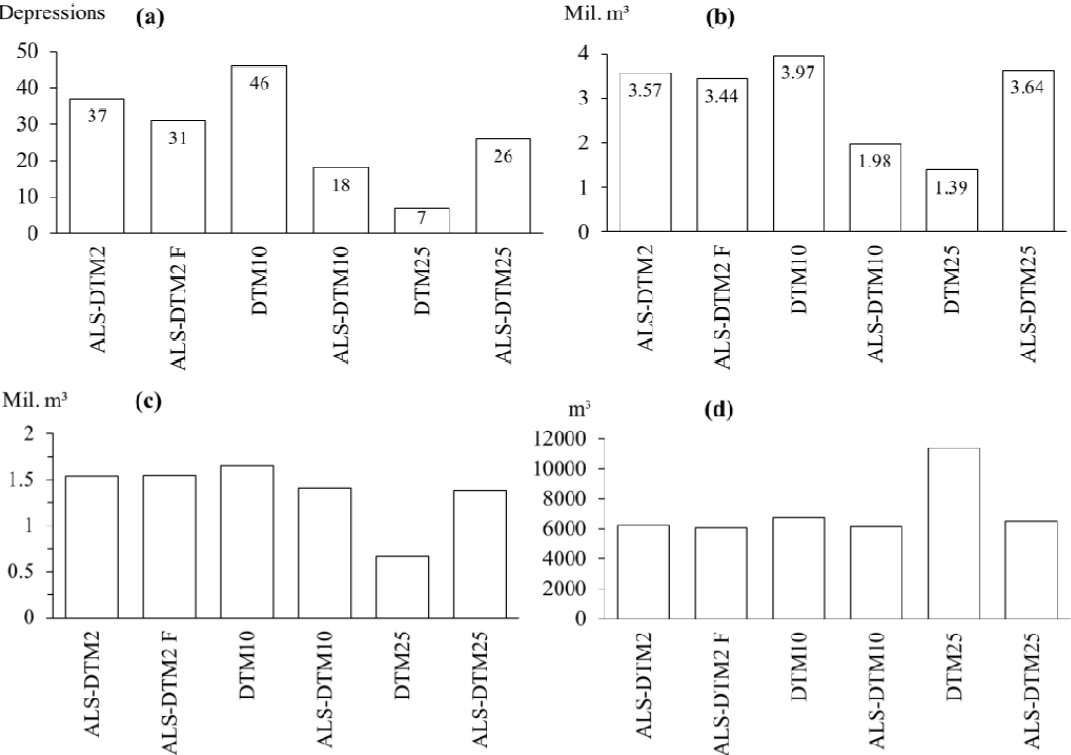
Figure 8. The modelled detention areas for water: ( a ) number ;and ( b ) volumes of depressions that met the set criteria; ( c ) maximum and ( d ) minimum volumes of depressions